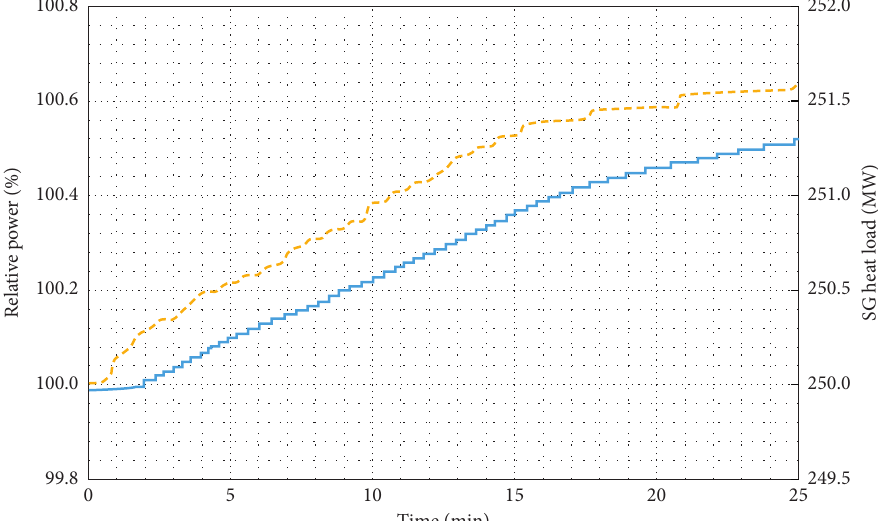
Figure 14: Relative power and SG heat load of #1 module in case 1 (solid line: relative power; dashed line: SG heat